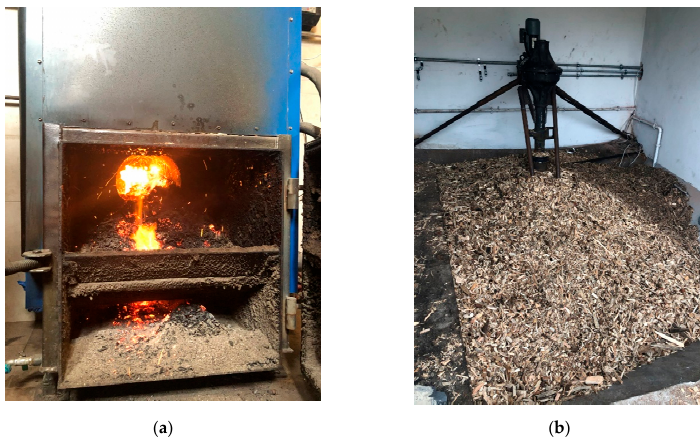
Figure 2. Low-emission heating devices: ( a ) Combustion chamber; ( b ) fuel storage with a